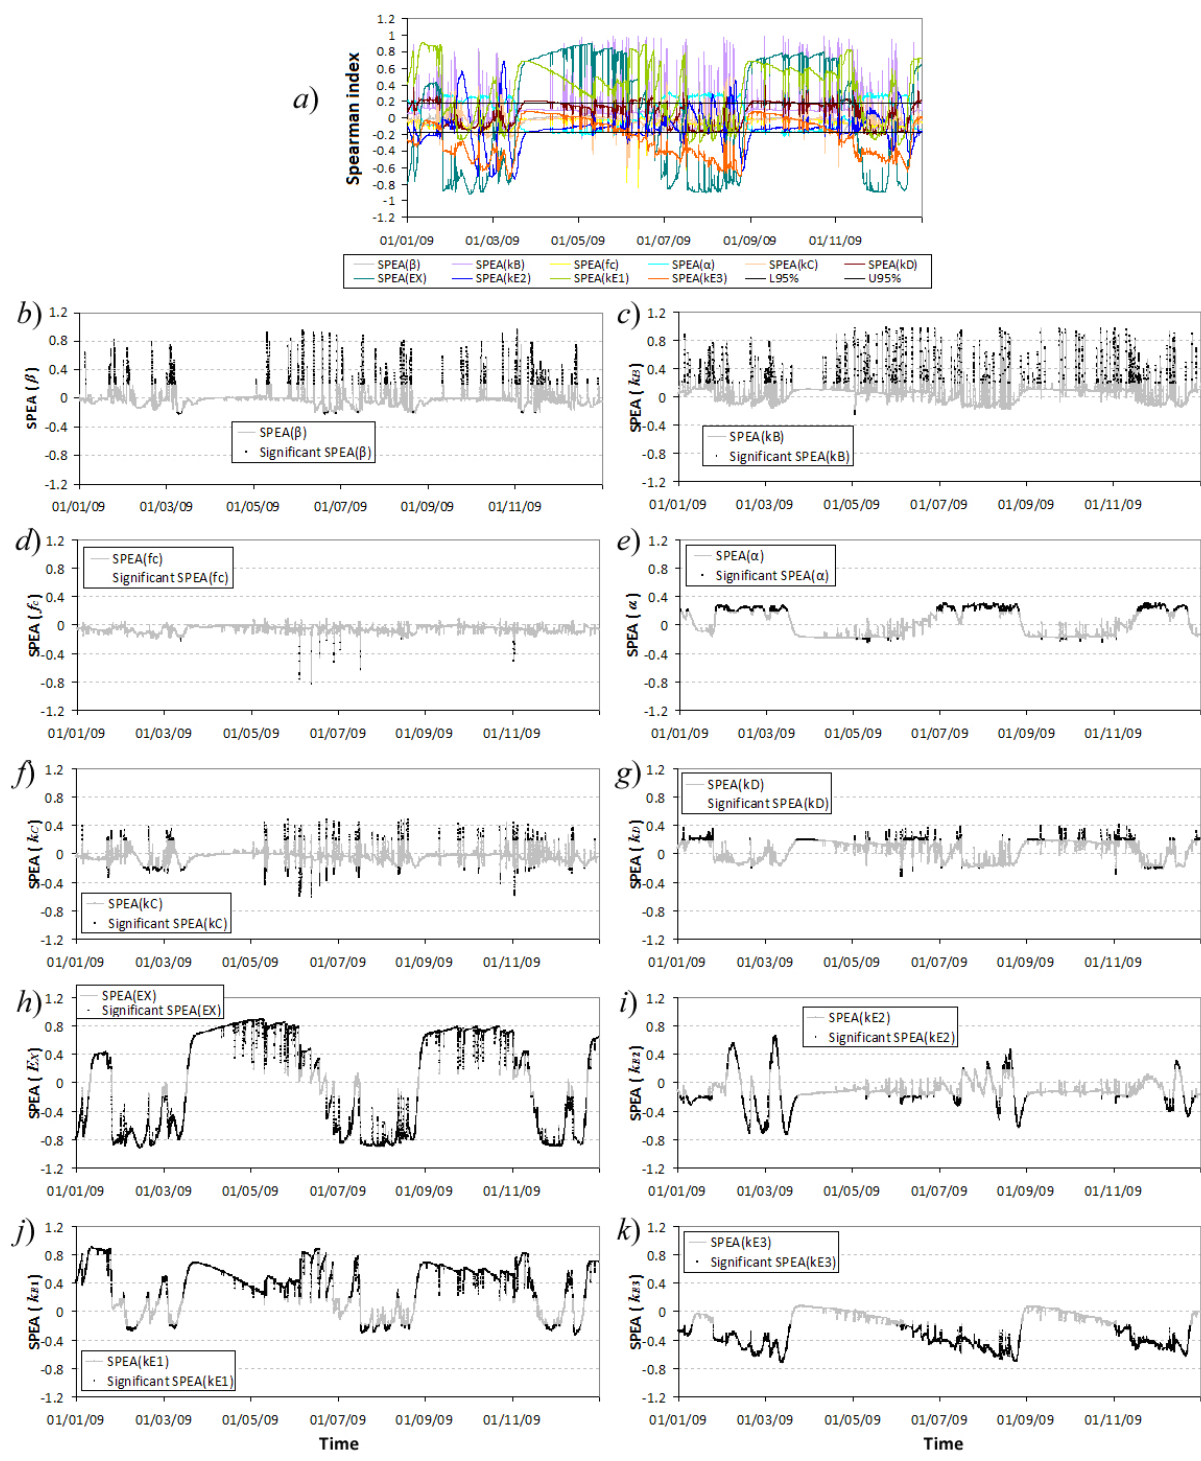
Fig. 10. Spearman indexes between Q and: (a) all the parameters: black horizontal lines indicate the 95% confidence interval out of which the Spearman is significant, (b) partition parameter β , c ) surface discharge k B , (d) infiltration rate at field capacity f c , (e) maximum infiltration α , (f) root-reservoir discharge k C , (g) non-root discharge k D , (h) threshold for shallow aquifer E X , (i) shallow aquifer discharge k E2 , (j) deep aquifer discharge k E1 and (k) deep percolation discharge k E3 . The black dots indicate the time steps for which the Spearman is significant at the 95% confidence level, while grey dots indicate non-significant